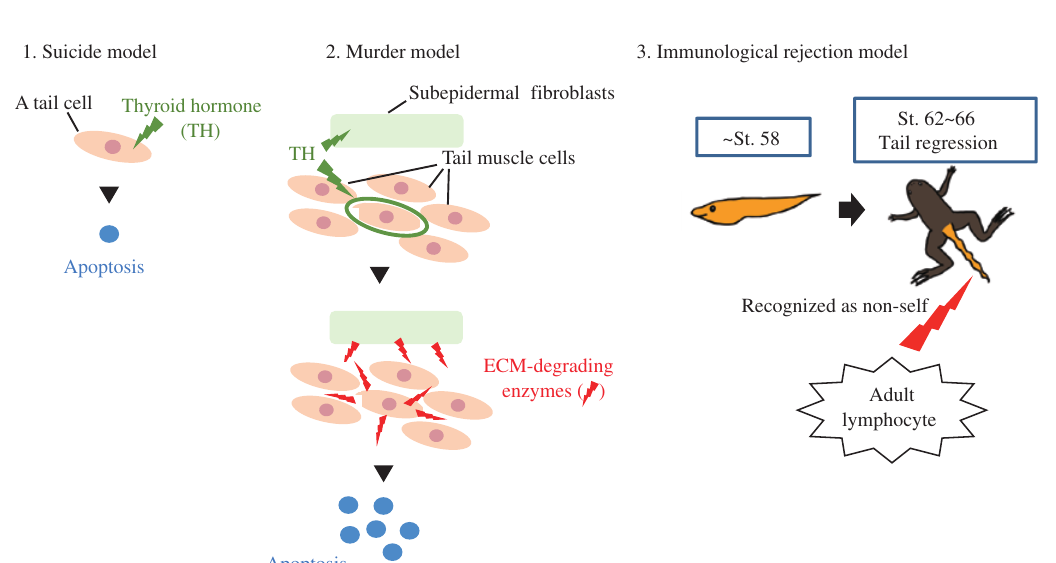
Figure 1: Models of tail resorption in amphibian